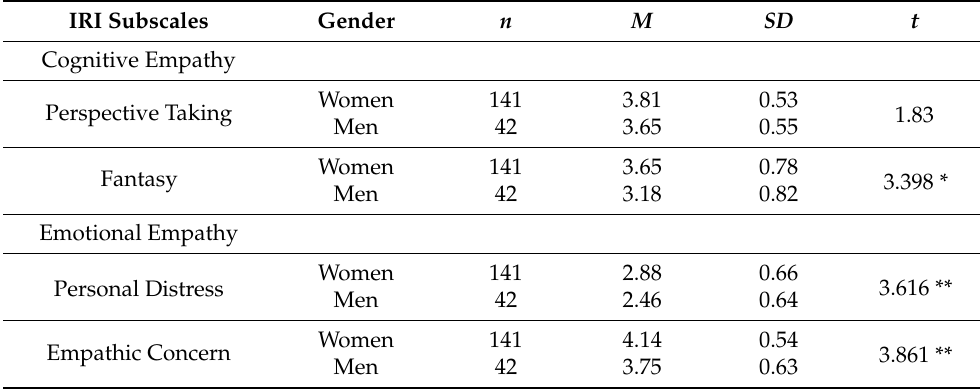
Table 1. Empathy by